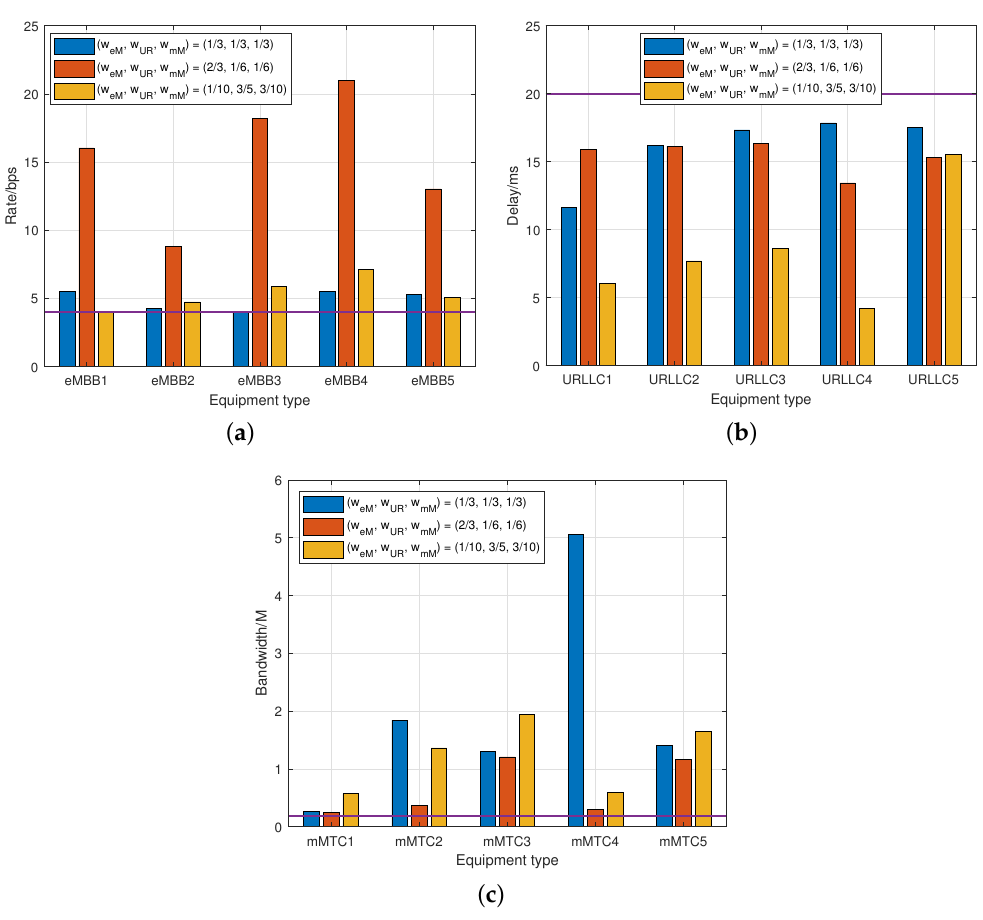
Figure 9. Network service constraints for devices in different network slices with various weights combi- nation. ( a ) The achieved transmission rate of devices in eMBB network slice; ( b ) the achieved delay of devices in URLLC network slice; ( c ) the achieved bandwidth of devices in mMTC network